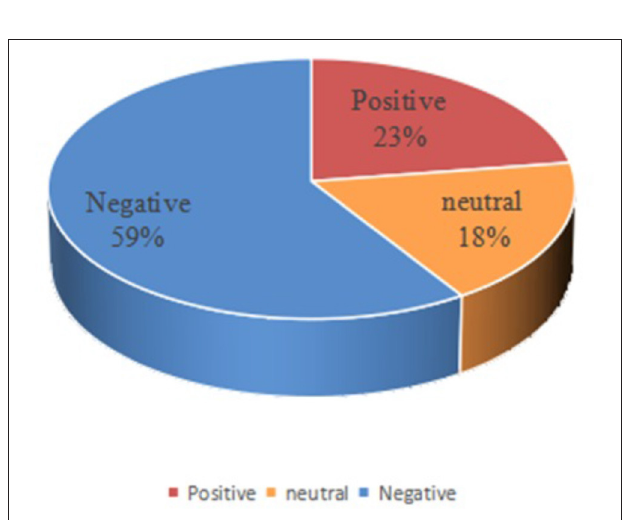
FIGURE 5 | Distribution of emotion analysis of migrant works’ “wages”. Figure 6 . In the early 2017, December 2017 to January